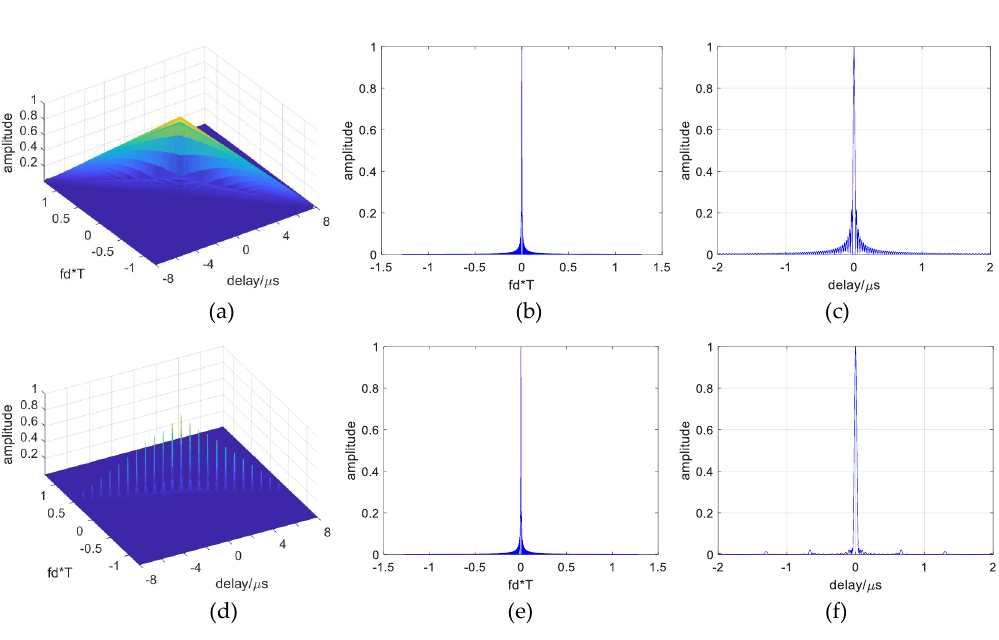
Figure 9. Self-ambiguity functions and their zero-delay and zero-Doppler “cuts”. ( a ) Conventional OFDM waveform; ( b ) zero-delay cut; ( c ) zero-Doppler cut; ( d ) designed OFDM chirp waveforms; ( e ) zero-delay cut; ( f ) zero-Doppler cut.